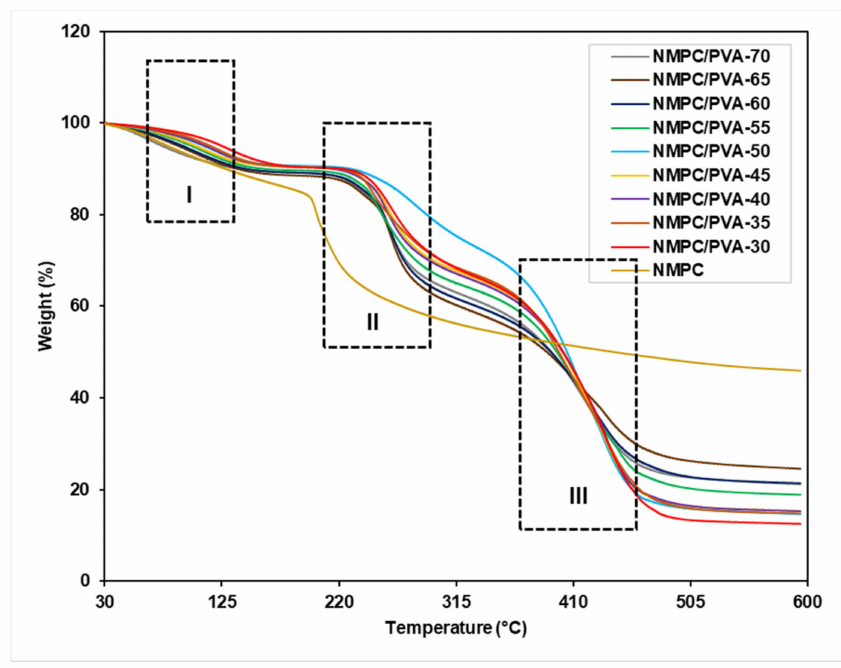
Figure 4. TGA curves of the NMPC membrane and NMPC/PVA composite membranes with different